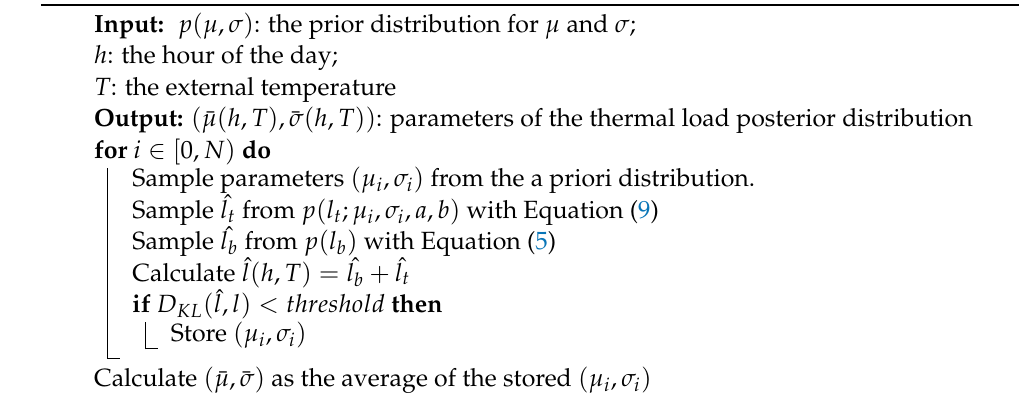
Algorithm 1: ABC rejection algorithm for thermal load prior